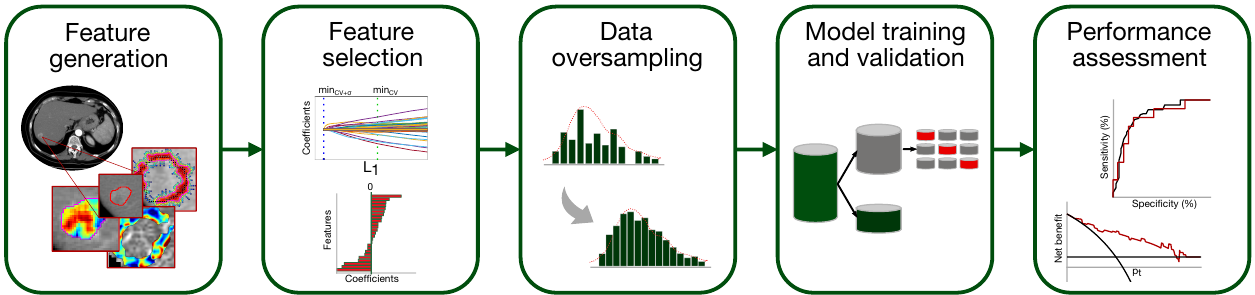
Figure 3. Pipeline of the classification model development for MVI